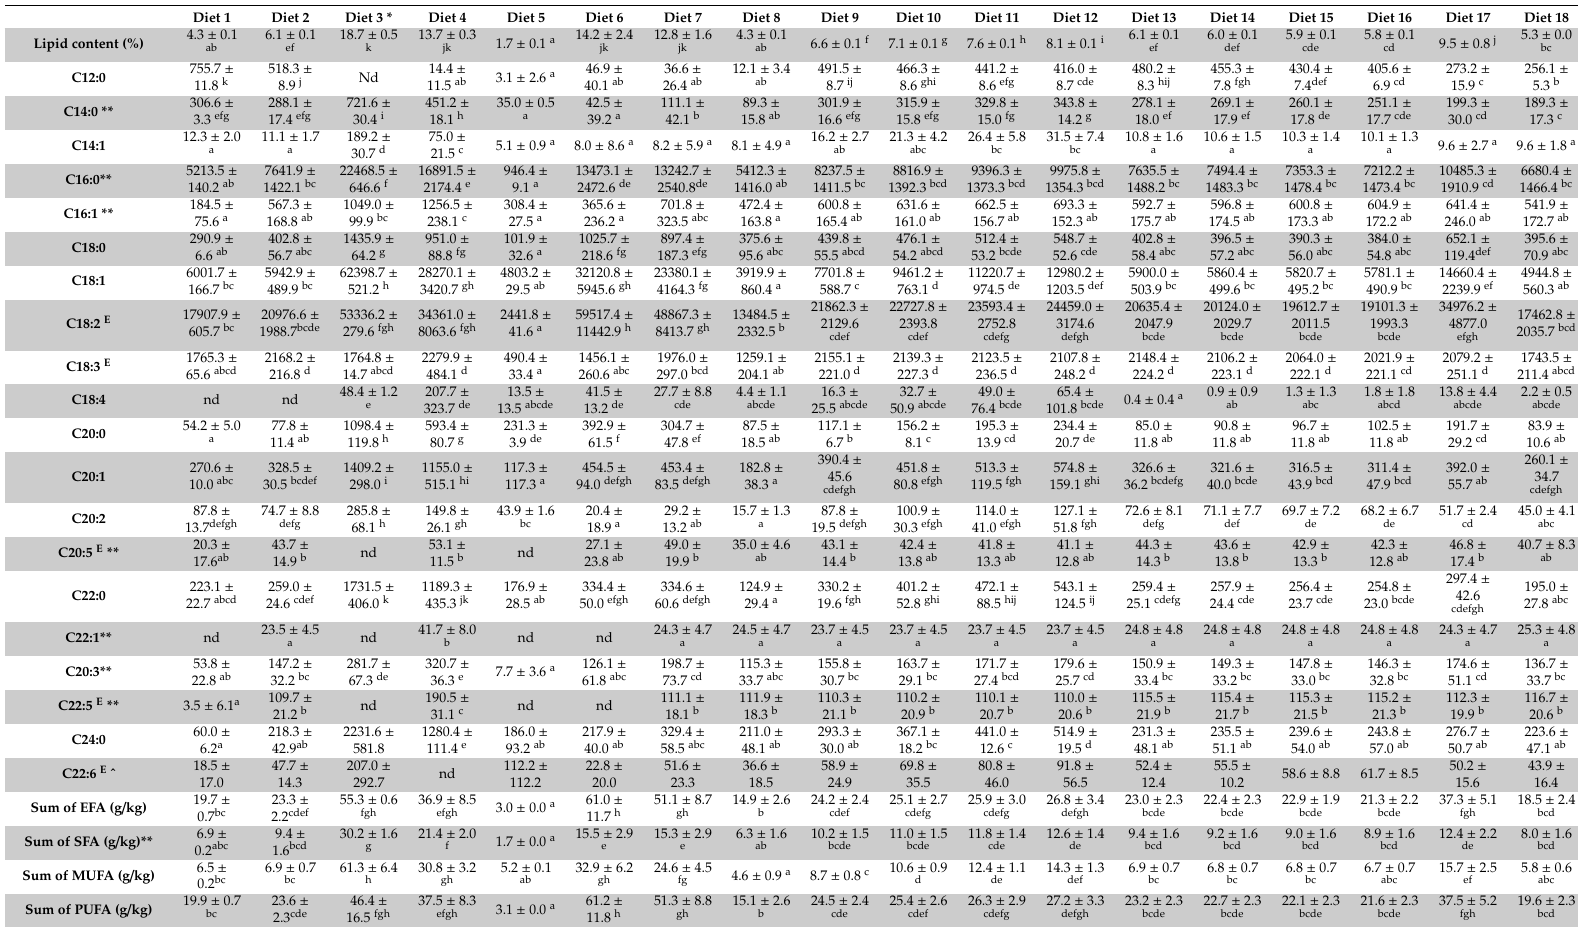
Table A3. Lipid content (%), fatty acid profile (mg / kg) and sum of essential fatty acids (g / kg) of the diets on dry matter basis (mean ± SD), E essential fatty acids, * analysis performed in duplicate, EFA: essential fatty acids, SFE: saturated fatty acids, MUFA: monounsaturated fatty acid, PUFA: polyunsaturated fatty acids, nd: not detected, ** ANOVA analysis followed by Tukey post-hoc (letters in superscript), others were analyzed by Kruskal–Wallis (ˆ indicates if no significant di ff erences were